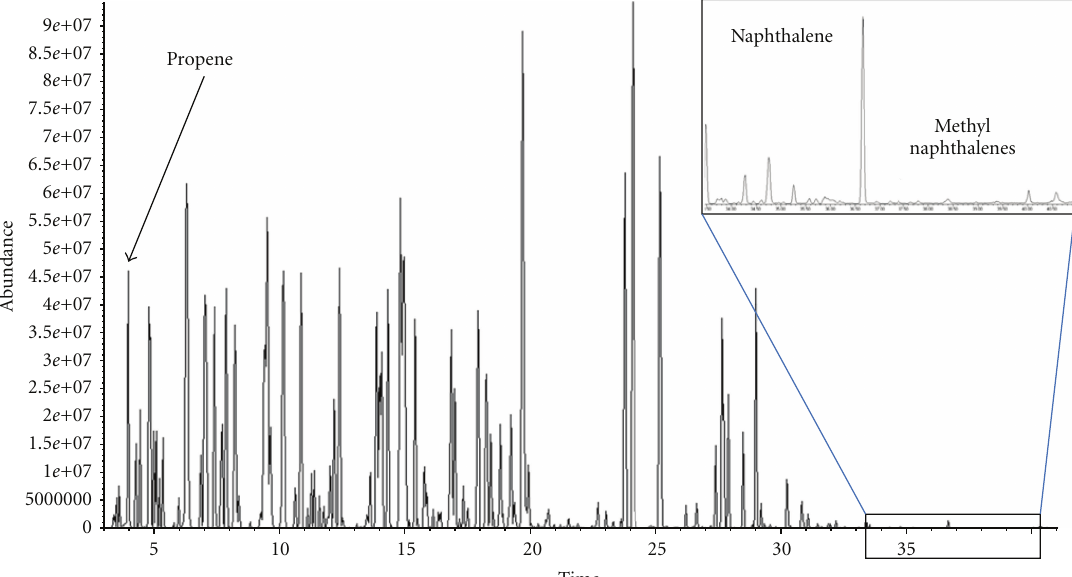
FIGURE 10: Chromatogram of a 50 mL sample of air taken near a diesel exhaust, analysed using TD- GC/TOF MS (TD; TD-100, Markes International Ltd, TOF MS; BenchTOF-dx, ALMSCO International Ltd, UK). Note the quantitative retention of C 3 hydrocarbons on a tube rated for C 4 / 5 to C 30 . Method conditions